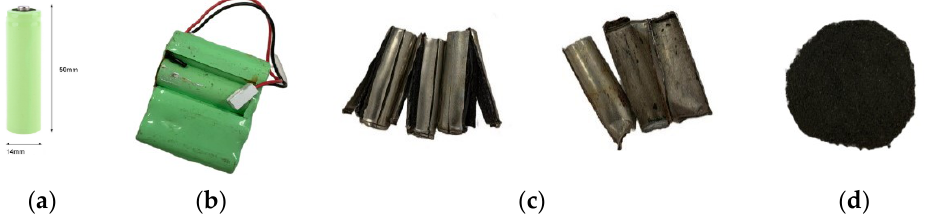
Figure 7. Spent NiMH batteries ( a ) The size of the typical NiMH battery, ( b ) Cases of spent cells, ( c ) Housings and small plastic parts, ( d ) Black battery mass. ( c ) Housings and small plastic parts, ( d ) Black battery